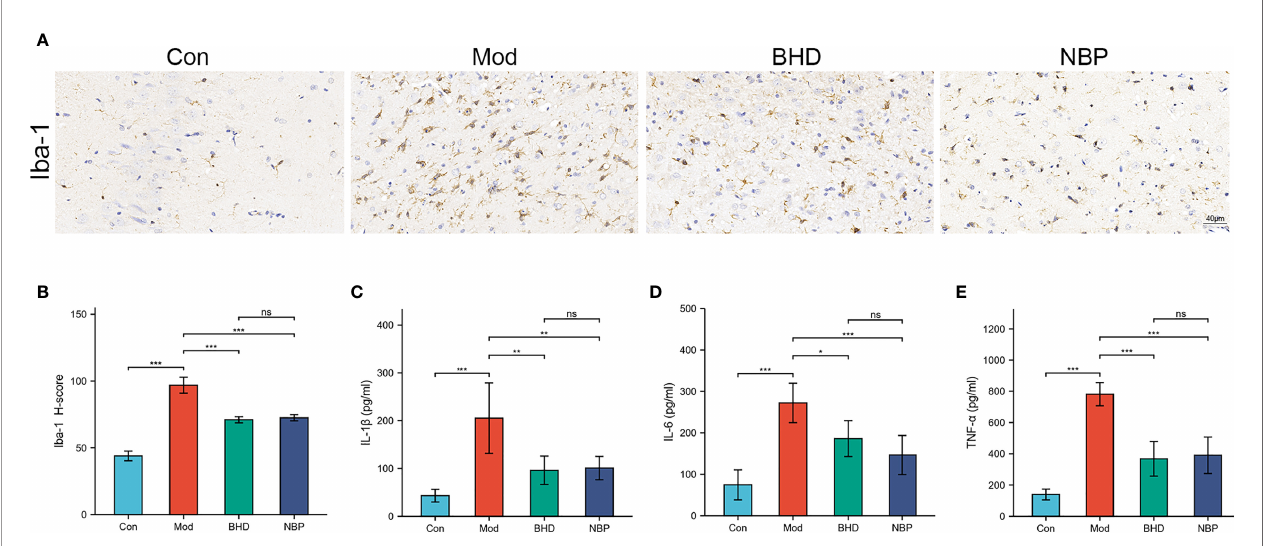
FIGURE 5 | Effects of BHD on microglia in the brain and peripheral proin fl ammatory cytokines in rats with CI. (A, B) Quanti fi cation of Iba-1-positive cells in the ischemic brain tissue of rats (n = 4 per group). (C-E) Serum levels of IL-1 b , IL-6, and TNF- a (n = 6 per group). All the data are presented as the mean ± SD. Differences were assessed by one-way ANOVA: *** p < 0.001, ** p < 0.01, * p < 0.05. ns, not statistically signi fi cant. n = 8 per